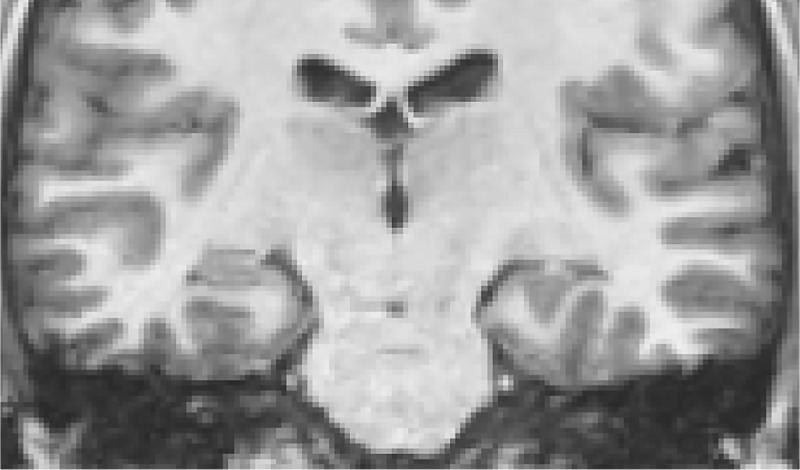
T1 weighted MRI in a coronal view.The left hippocampus (right side in the image) presents an incomplete hippocampal inversion (IHI). The right hippocampus (left side in the image) is an example of a normal or properly inverted hippocampus.